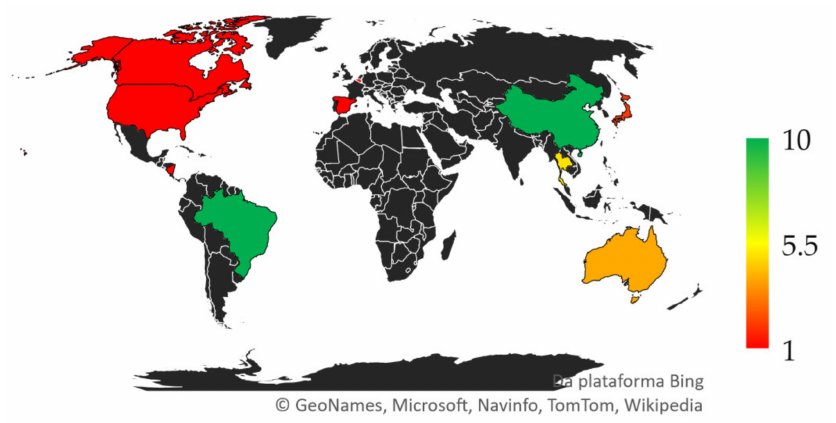
Figure 3. Spatial distribution of research in UAVs for sugarcane.